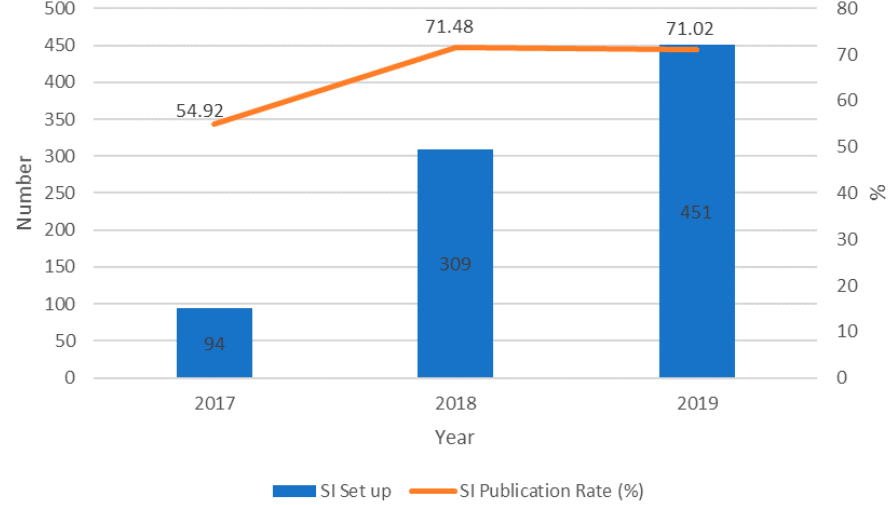
Figure 6. The new Special Issues (SIs) set up and the rate of publications for SIs in the past three years in the Remote Sensing Open Access Journal of MDPI.